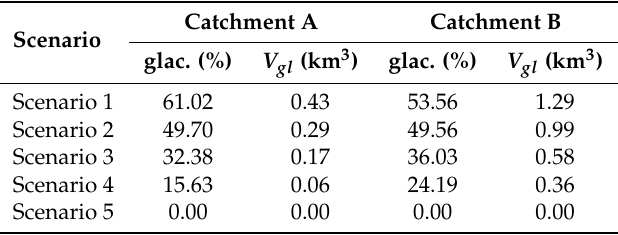
Table 2. Glacierization (glac.) and glacier ice volume ( V gl ) in each scenario. Scenario 1 has the largest glacier volume and Scenario 5 has no glacier left. The spatial extent of the glaciers is shown in Figure